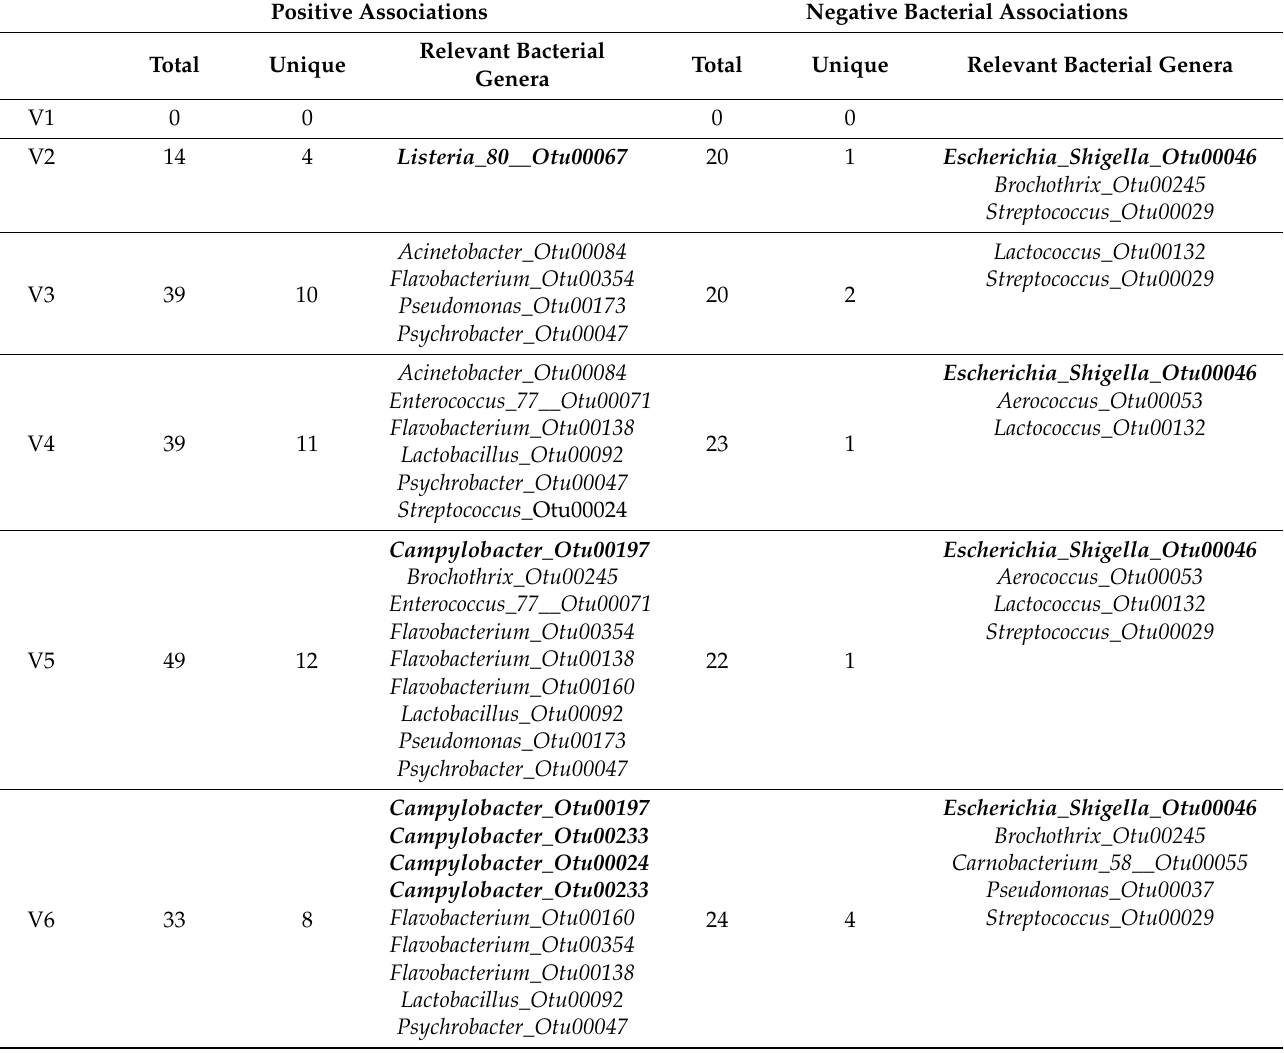
Table 5. Relevant bacteria (i.e., commonly known bacterial genera that can include potential spoilage species or potential foodborne pathogen species) extracted from the list of OTUs identified using the MaAsLin test and associated with the different